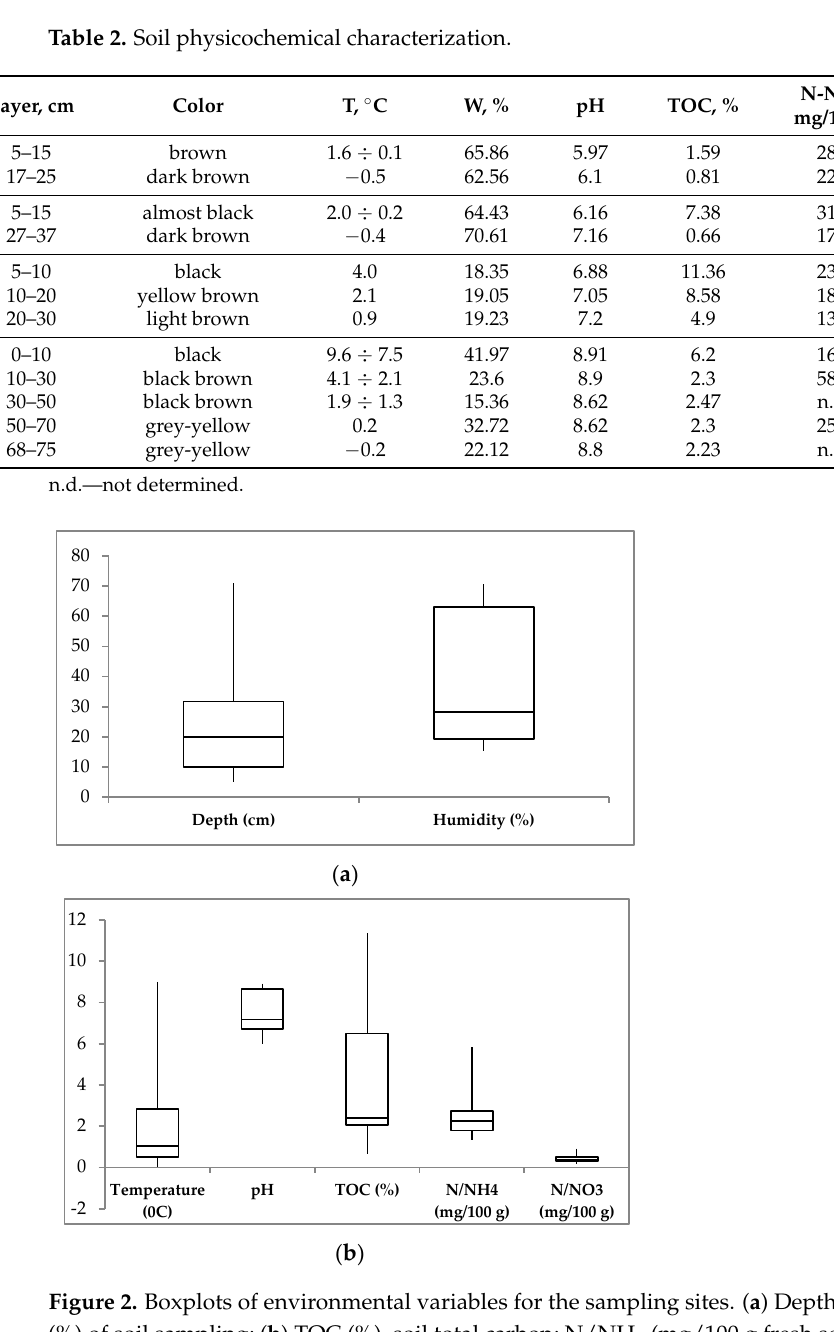
Table 2. Soil physicochemical characterization.